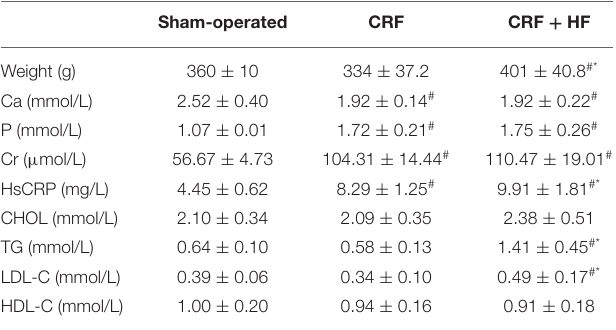
TABLE 1 | Comparison of body weight and serum biochemical indexes of rats in each group.